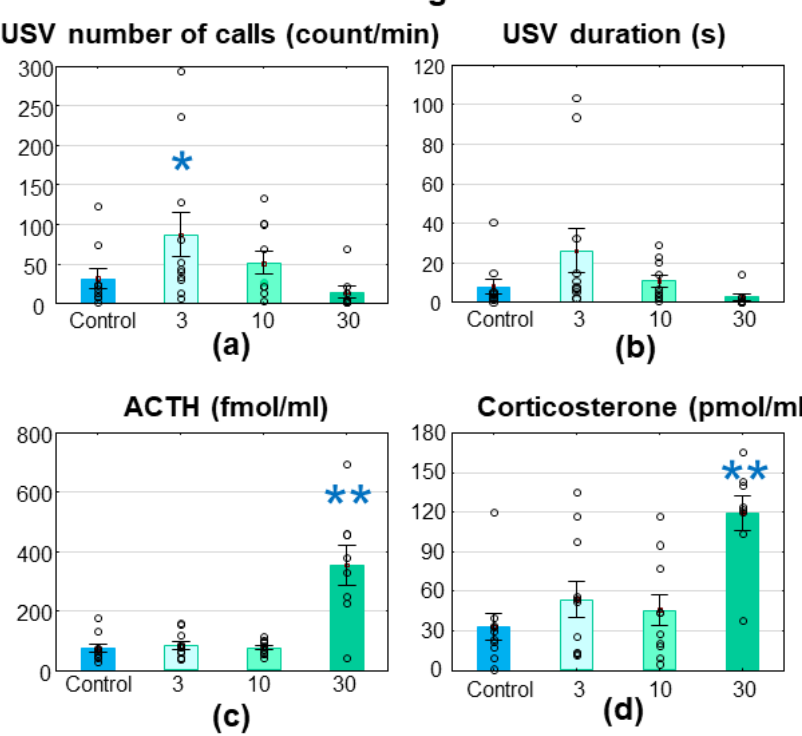
Figure 4. Wistar rats, treated with SR121463B, a a vasopressin (V) 2R antagonist. The 7–8-day-old Wistar rat pups were treated intraperitoneally with a 3, 10 or 30 mg/kg V2R antagonist 30